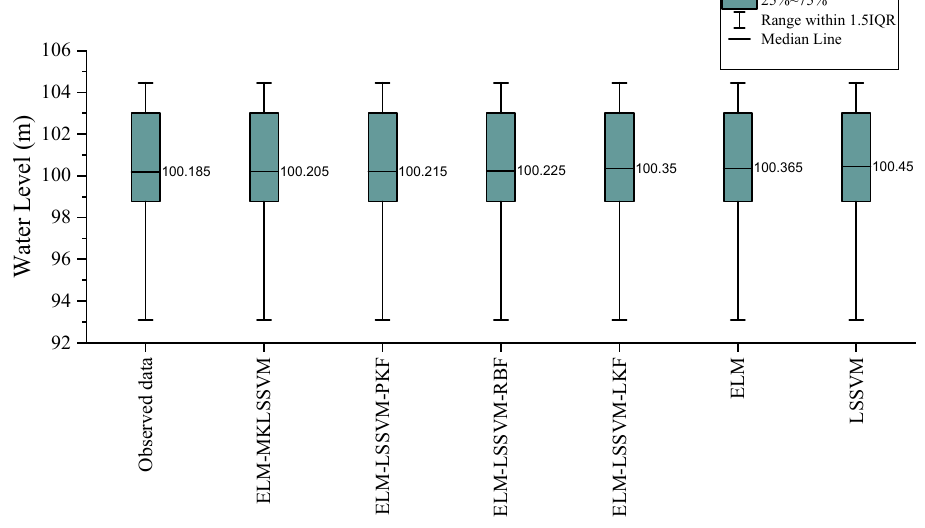
Figure 5. Boxplots of hybrid LSSVM models.